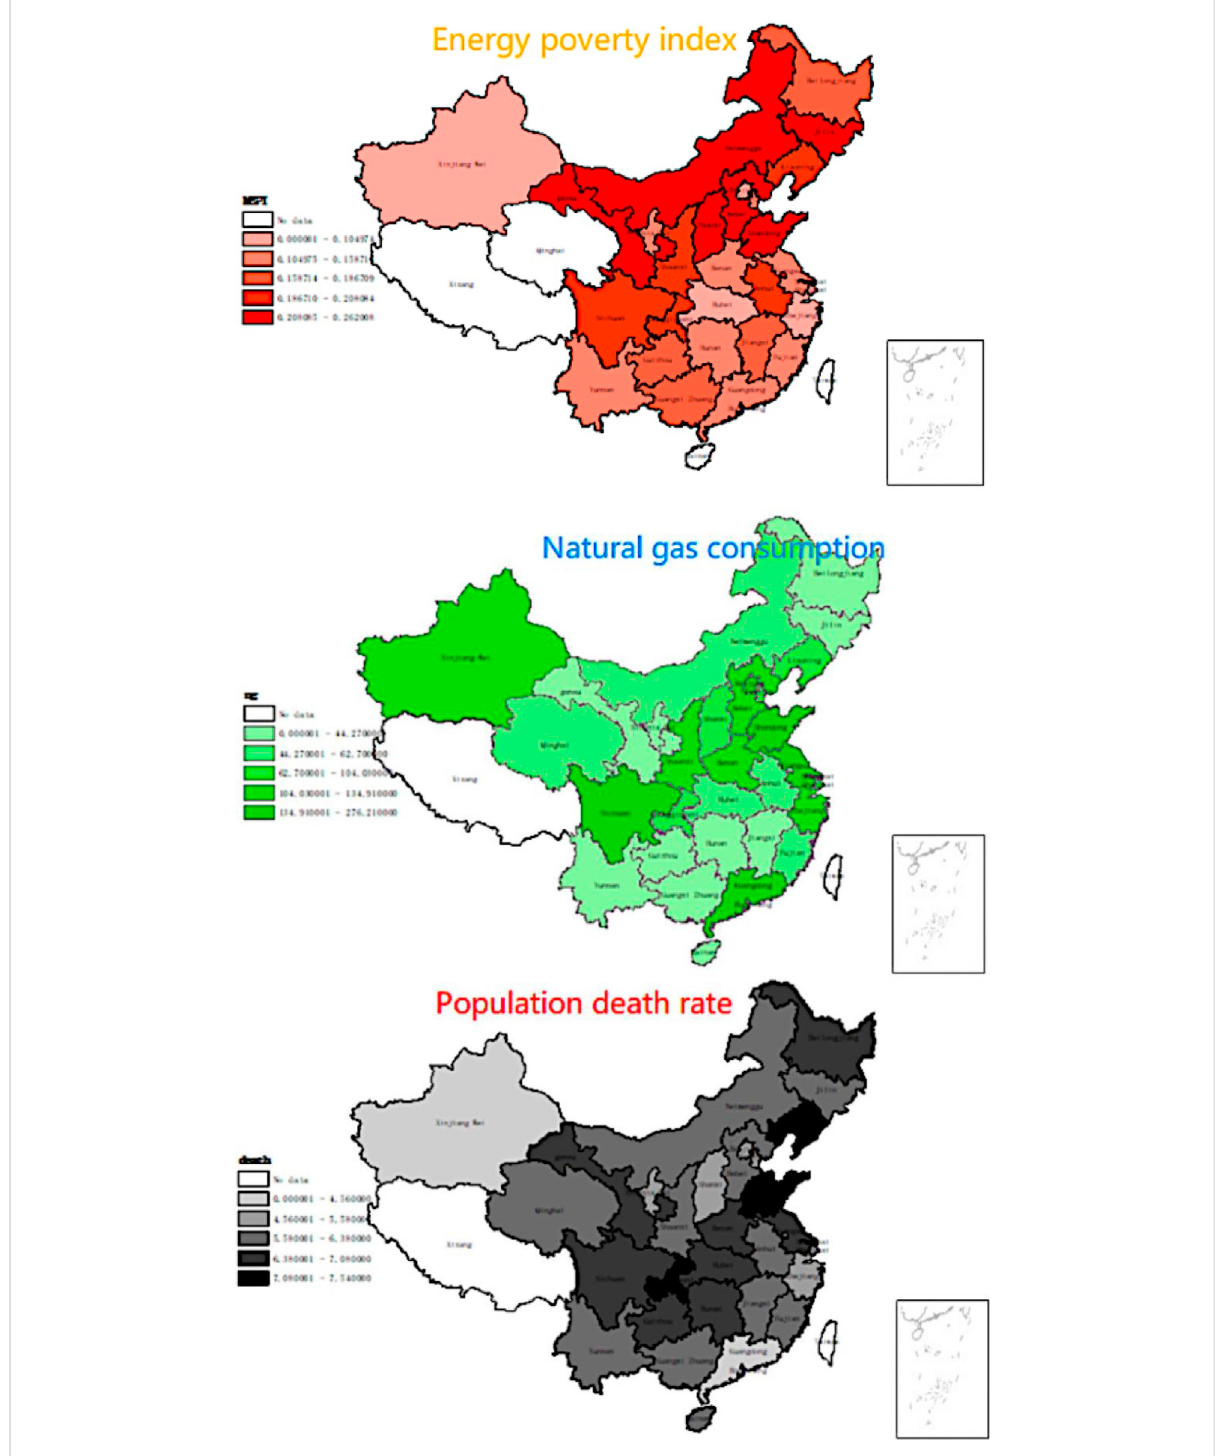
FIGURE 6 Comparison of the spatial distribution of energy poverty, natural gas consumption, and population mortality in